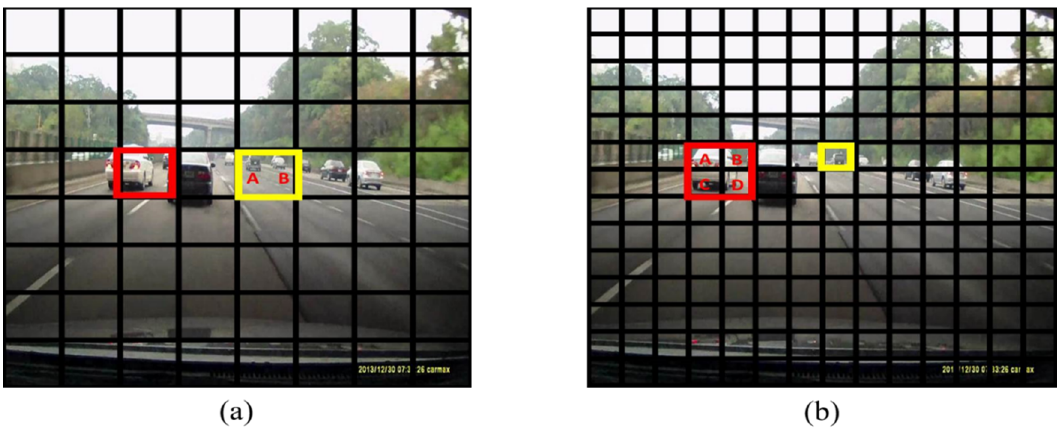
Figure 3. Visual analysis of different settings of bounding box regressors (BBRs). ( a ) Tiny objects (A and B) would locate in the same grid box. Ambiguous back-propagation results in lower recall rate. ( b ) Large objects (A, B, C and D) that cross the boundary of many grid boxes, makes a numerical unstable phenomenon during the training stage.